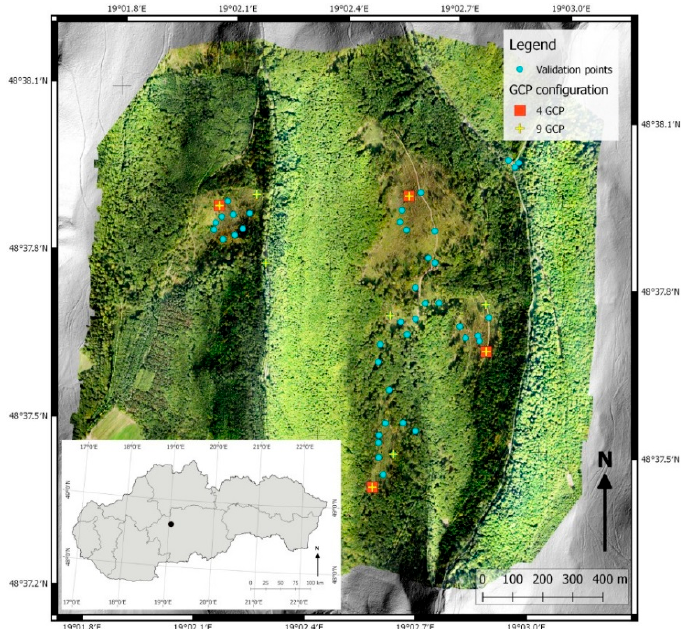
Figure 1. Study area and its location within Slovakia. Orthomosaicked images resulting from the unmanned aerial vehicle (UAV) flights are draped over hillshaded digital terrain model. Validation points (blue dots) and ground control points in the 4 ground control point (GCP) (red squares) and 9 GCP (yellow crosses) configurations are also shown in the map.